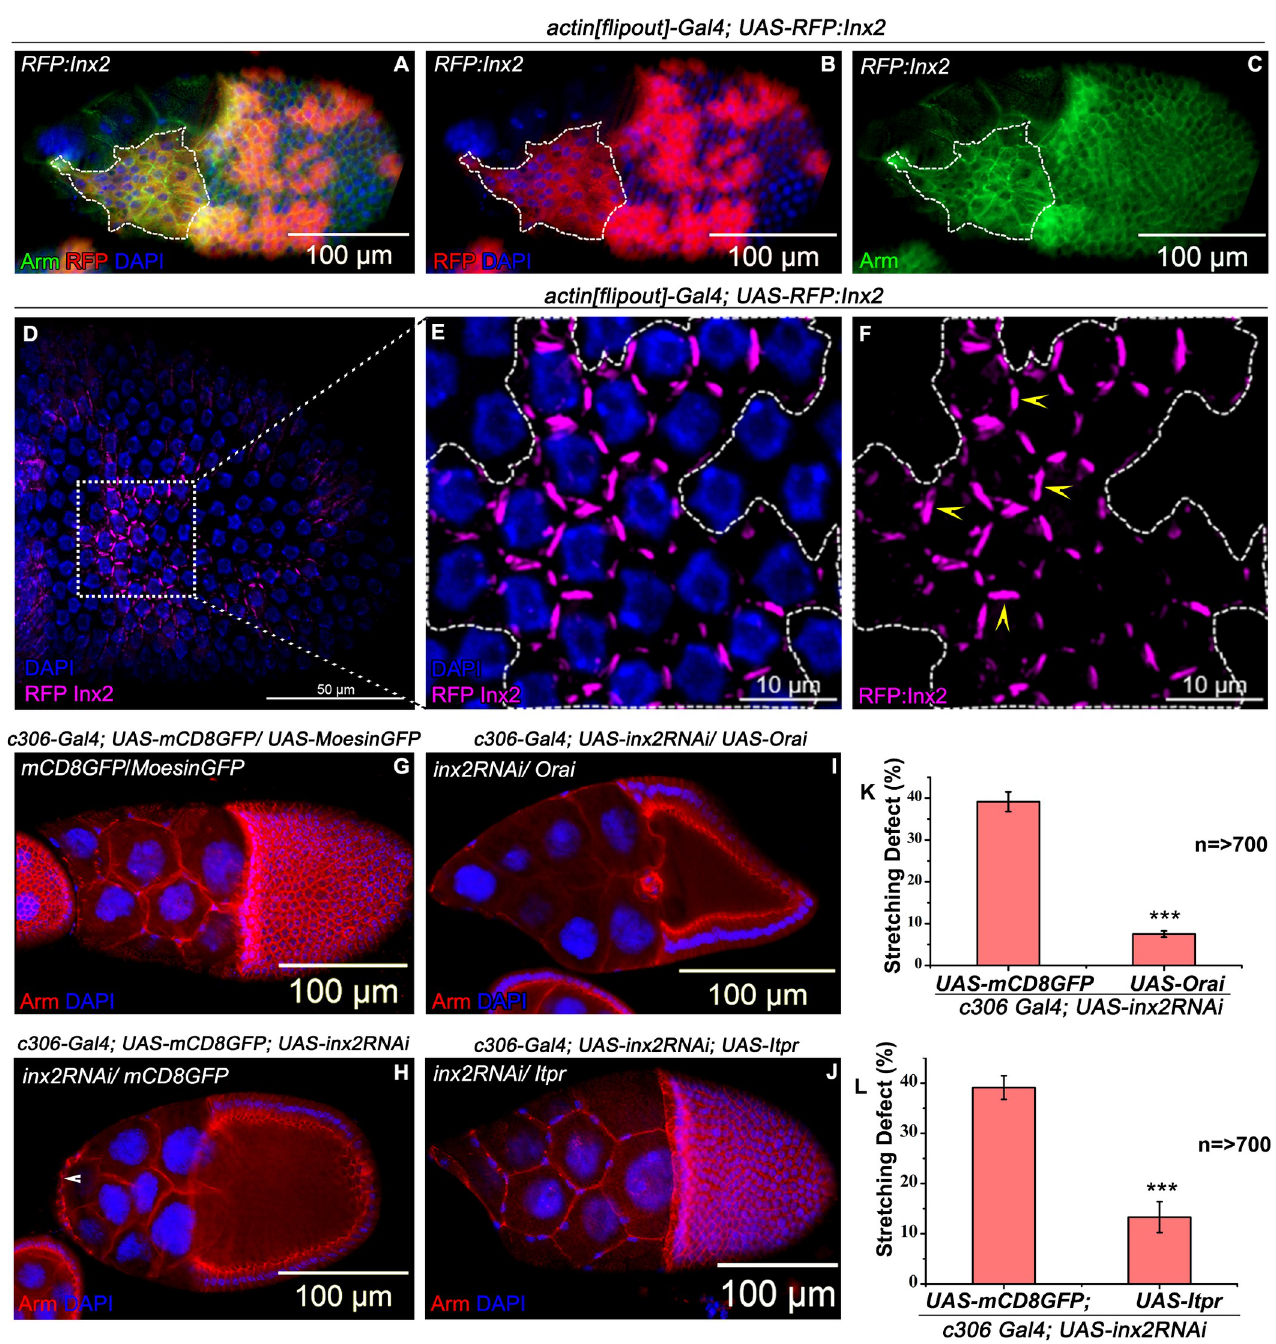
Fig 2. Channel activity of Inx2 affects shape change in AFCs. (A-F) Mosaic analysis-employing actin [Flipout] Gal4 resulting in overexpression of UAS-RFP: Inx2. (A-C) Overexpression of RFP:Inx2 in anterior follicle cells exhibiting stretching defect. A is merge of B and C. The clones overexpressing RFP:Inx2 are marked in Red. Armadillo is in Green. Highlighted dotted lines mark the unstretched follicle cells. (D-F) Distinct localization of RFP:Inx2 in posterior follicle cells. RFP is in Magenta and DAPI in Blue. Boxed outline in the D is magnified in E and F. Highlighted dotted outline in E and F marks the RFP:Inx2 overexpressing clone in the posterior follicle cells. Yellow arrow heads in F marks the distinct membrane localization of RFP:Inx2 protein. (G-L) Rescue of stretching defect by elevating level of intracellular calcium in the follicle cells. (K-L) Quantification of the stretching defect in the indicated genotypes. (G-I) Over expression of Orai in Inx2-depleted follicle cells mitigates stretching defects. Armadillo in Red and DAPI in blue. Arrowhead in H marks the unstretched follicle cells. (G-H and J) Partial rescue of the Inx2-depleted follicle cell phenotype by over expression of Itpr. Armadillo is in Red and DAPI in Blue. n = number of egg chambers analyzed. ��� indicates p-value < 0.001. Error bars represent Standard Error of Mean.